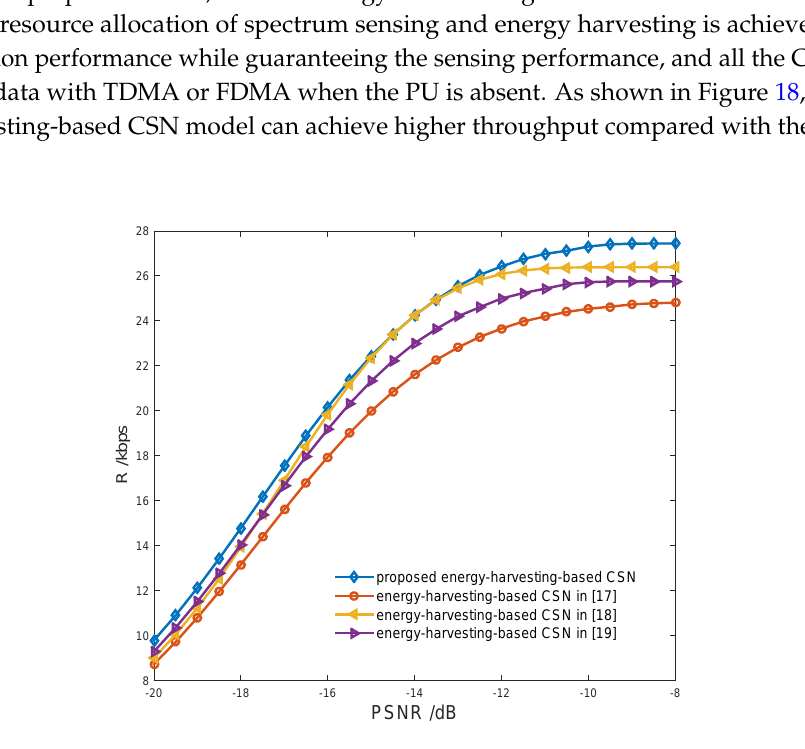
Figure 18. Transmission rate vs. energy-harvesting-based cognitive sensor network